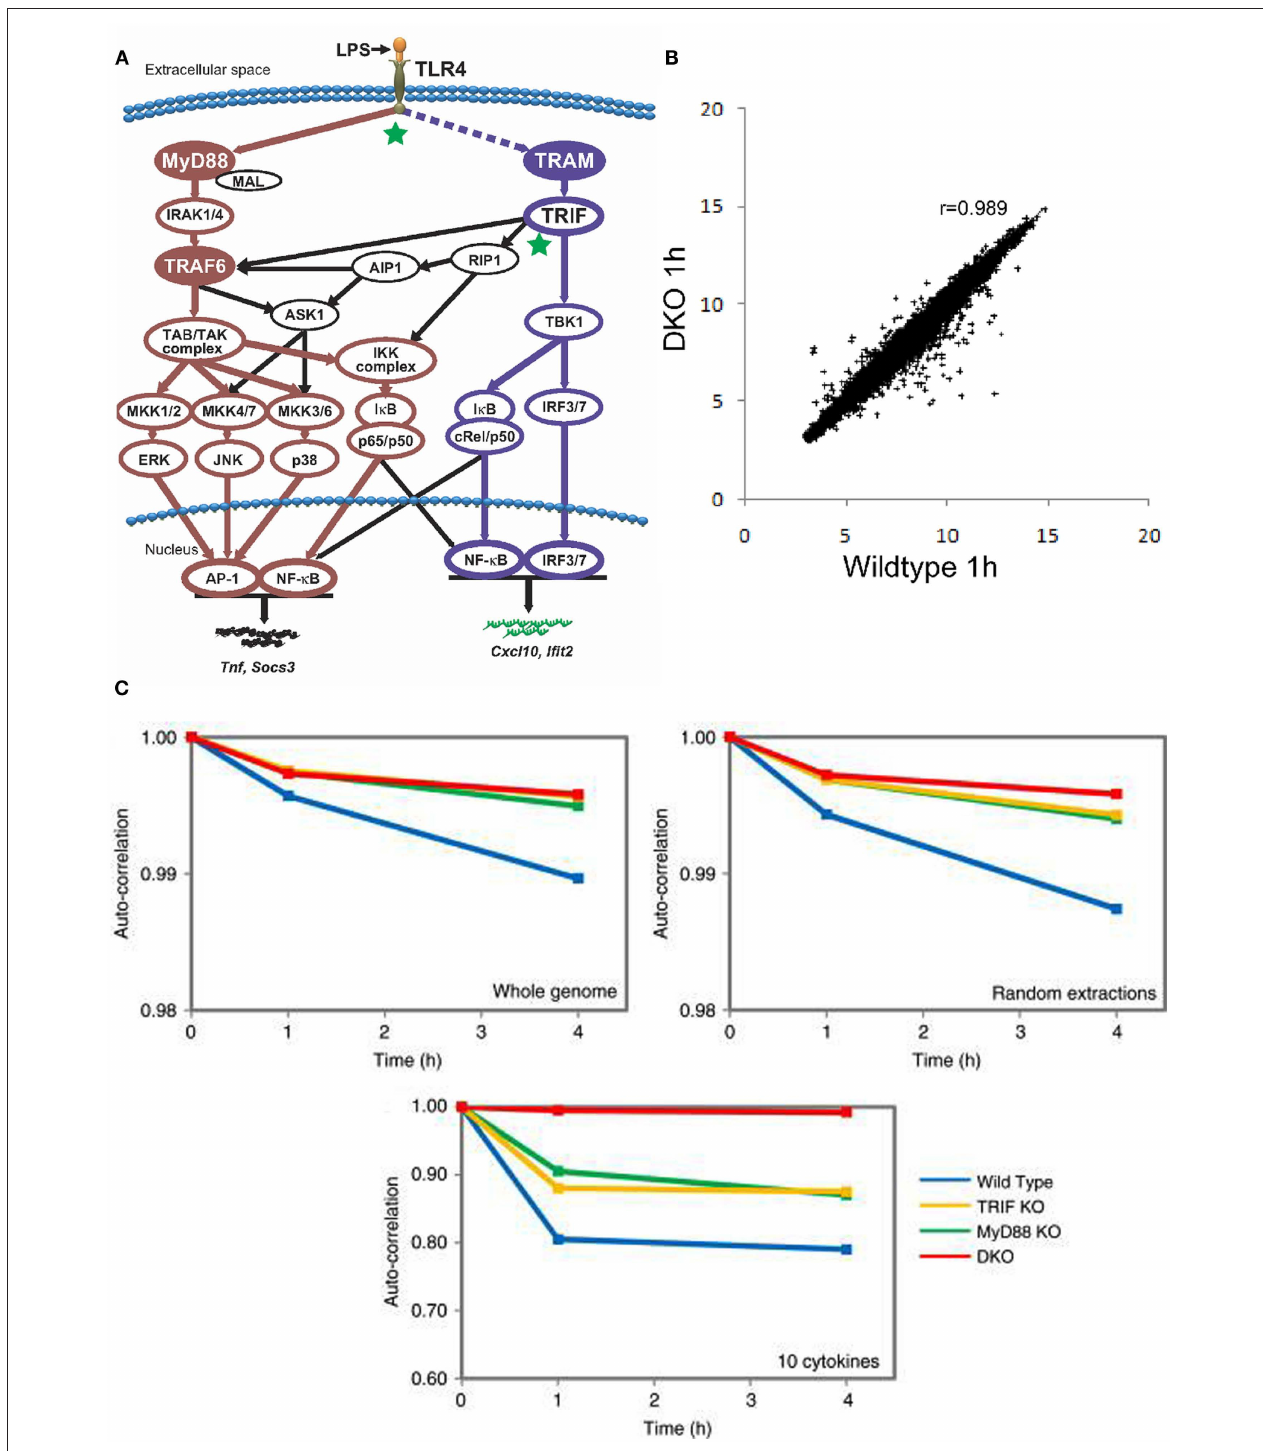
(C) Auto-correlations analysis for whole genome (upper left), random extractions of ORFs (upper right), and 10 important cytokines genes ( tnf , il1b , il12 , il6 , il8 , ccl3 , ccl4 , socs3 , socs1 , and cxc10 ; lower panel) after LPS stimulation (Tsuchiya et al., 2009b). x -axis represents time (in hours), and y -axis represents the correlation coefficient with t